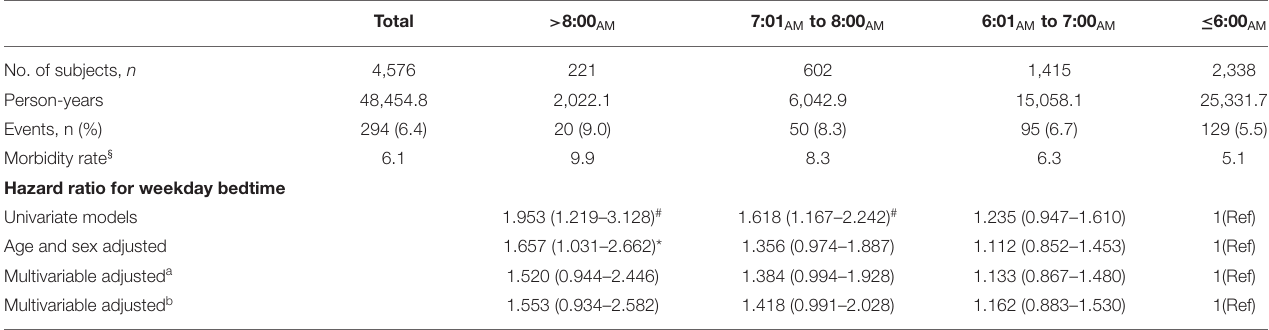
TABLE 3 | Hazard ratios and 95% CIs for wake-up time associated with MI on weekday.